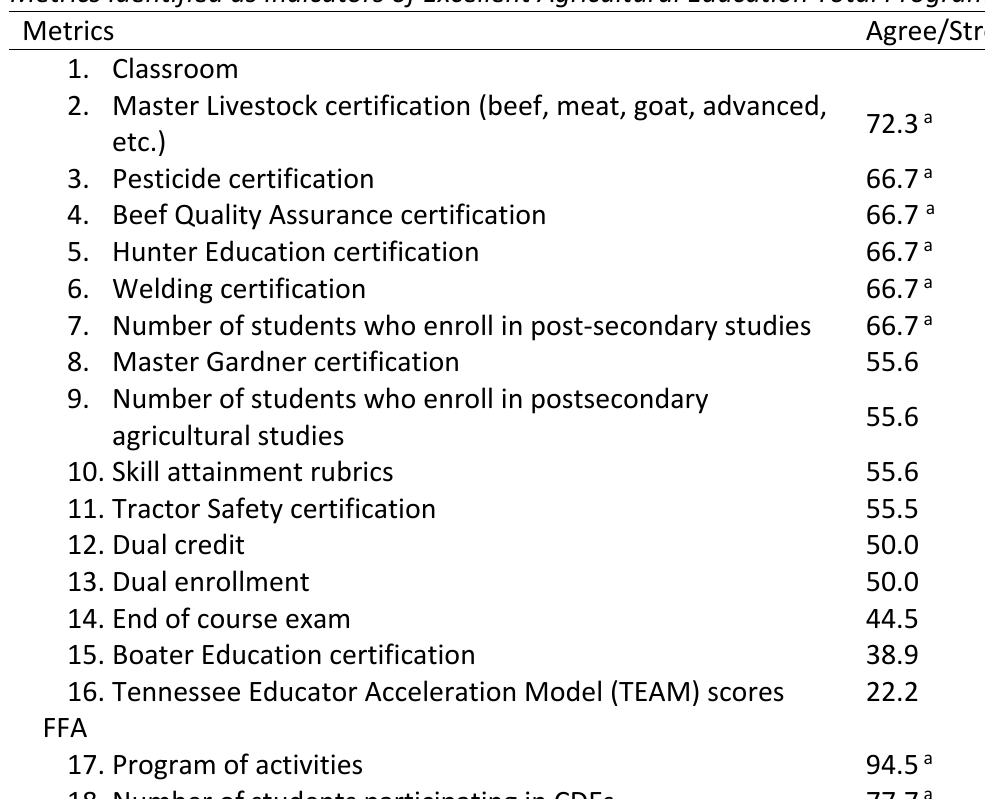
Metrics Identified as Indicators of Excellent Agricultural Education Total Programs Metrics Agree/Strongly Agree